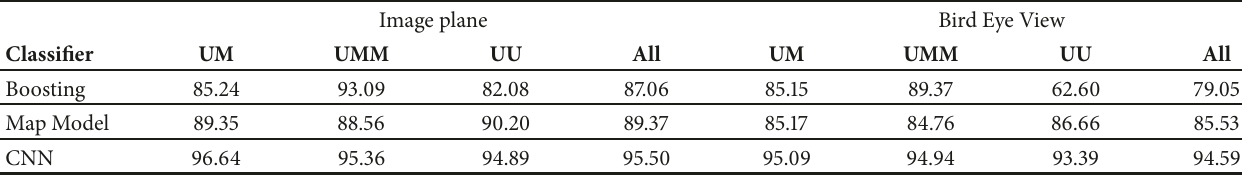
Table 4: Quantitative results on F-score in KITTI dataset.